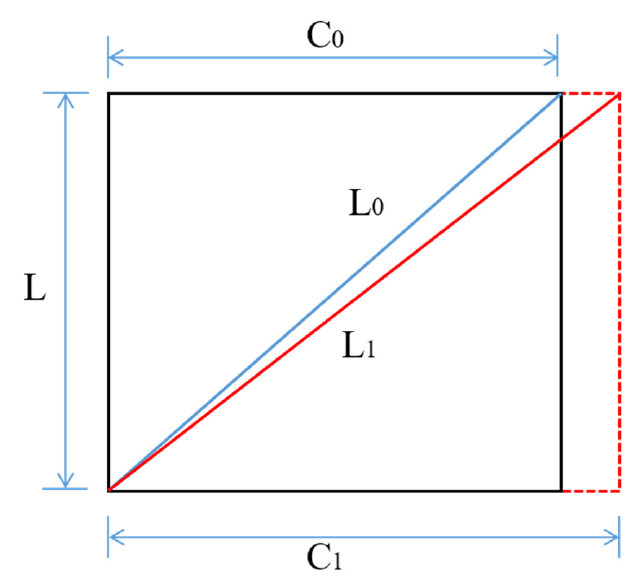
Figure 3. Two-dimensional sketch of unwind optical fiber. Plugging Equation (6) into Equation